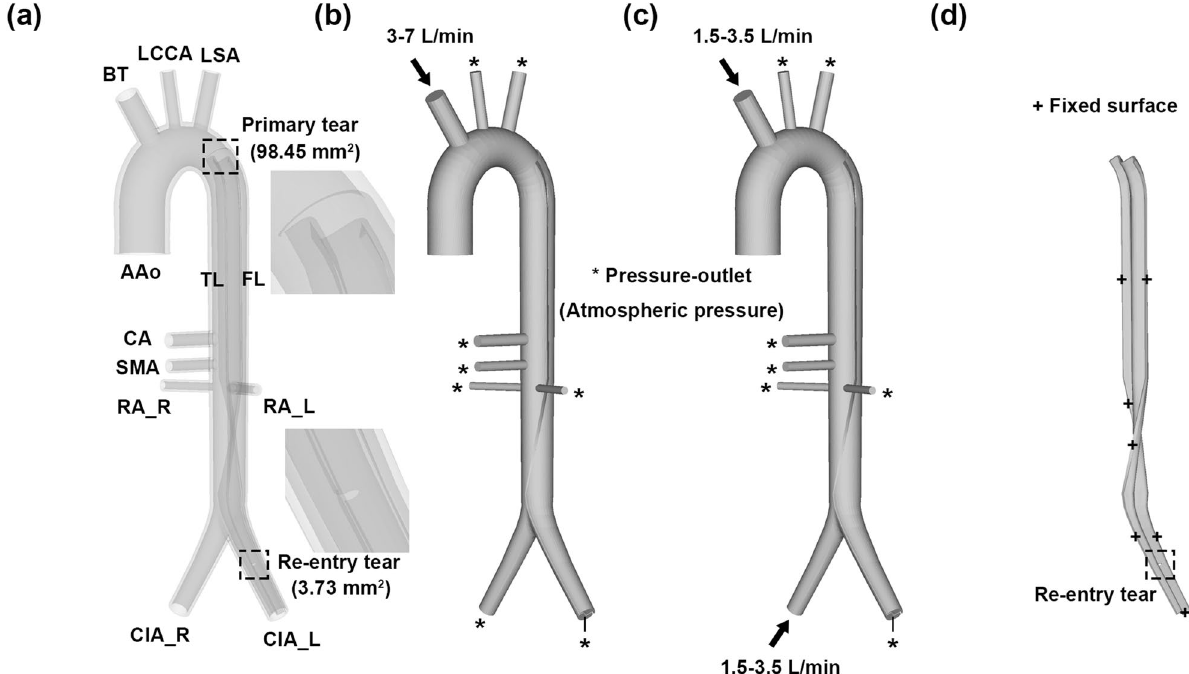
Figure 2. 3D geometries and boundary conditions of AD. ( a ) Idealized model of a dissected aorta, ( b ) fluid domain of AC, ( c ) fluid domain of AFC, and ( d ) intimal flap. These images were made with Ensight (v.2021 R1, https:// www. ansys.